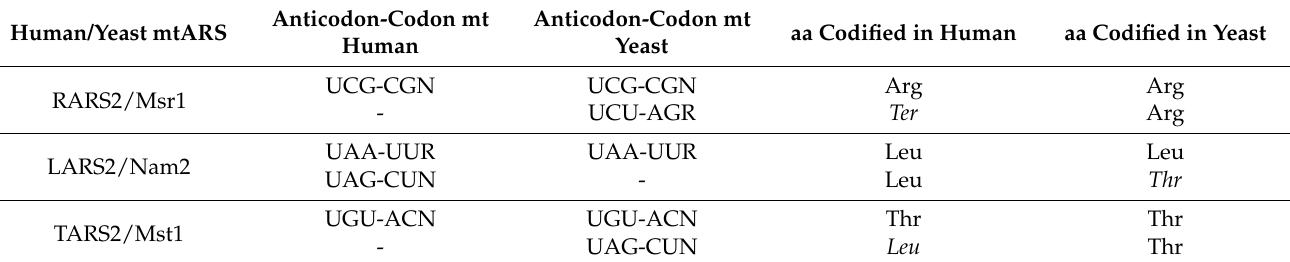
Table 3. Different anticodon/codon specificity for mt-tRNA in humans and in yeast. Amino acids not encoded according to the standard genetic code are highlighted in italics. N indicates any nucleotide, R a purine. Human/Yeast